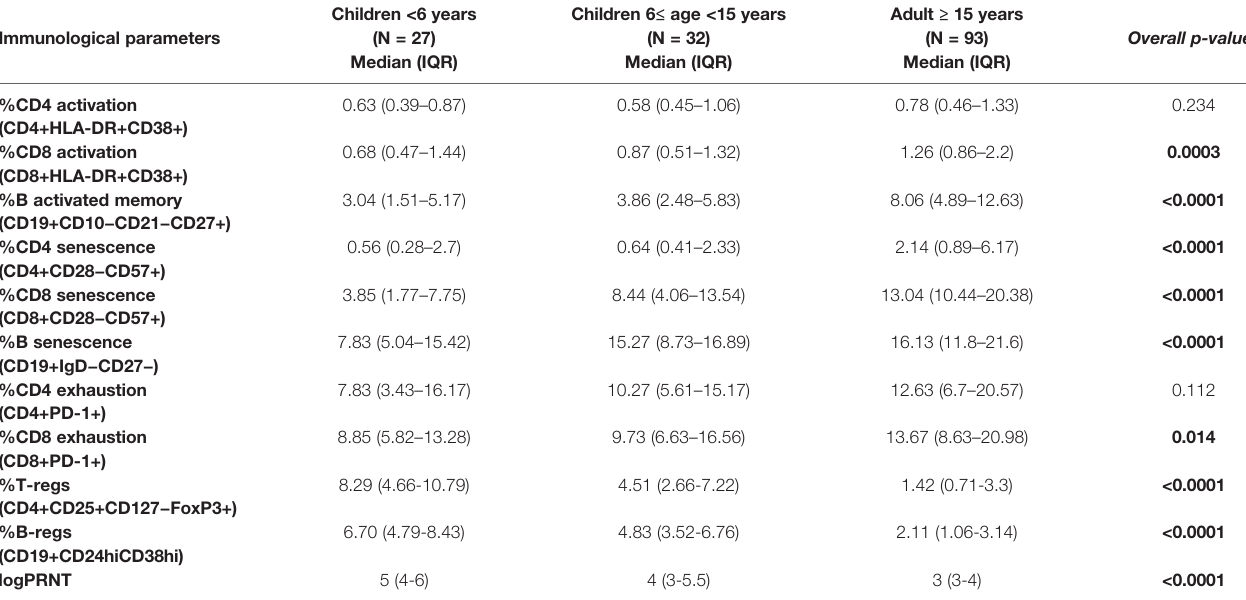
TABLE 2 | Immunological parameters in COVID-19 age classes at fi rst